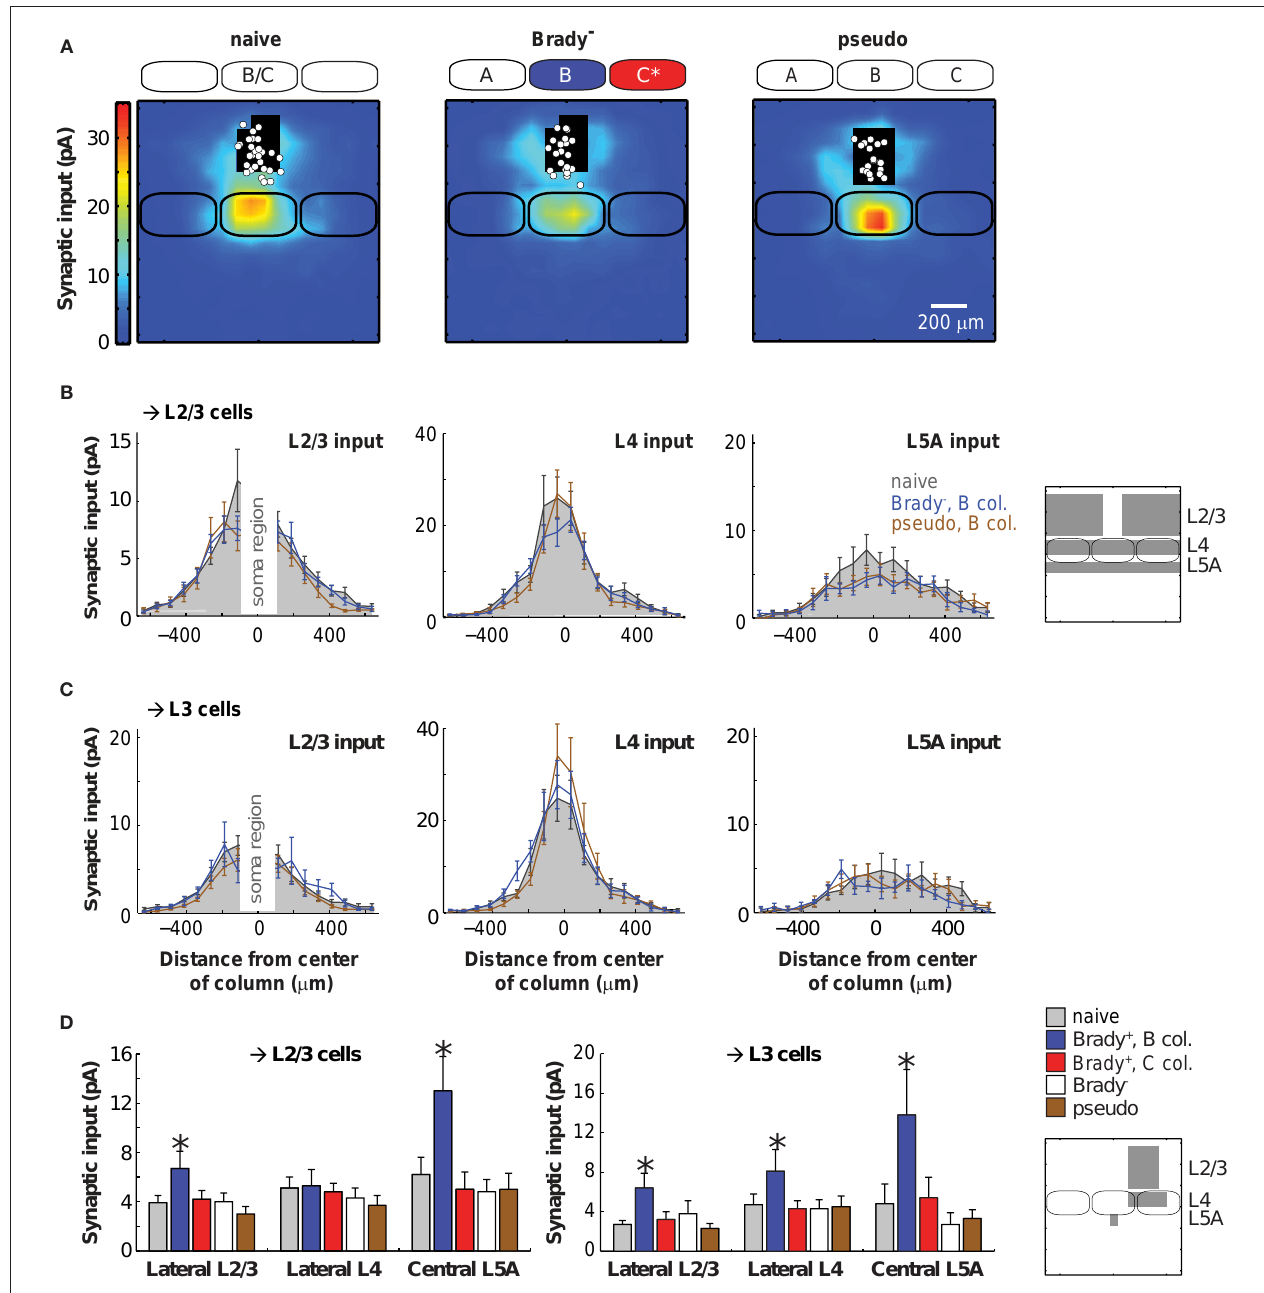
pseudoconditioned mice (brown). On the right, the analyzed regions of inputs are in gray. (C) Same as in B for L3 cells alone. (D) Summary of the effects of training on the synaptic inputs received by L2/3 and L3 cells in Brady + , Brady − , and pseudoconditioned mice. The stars indicate statistically significant differences compared to naive mice ( p < 0.05, Mann–Whitney). Regions of analysis are on the schematized map